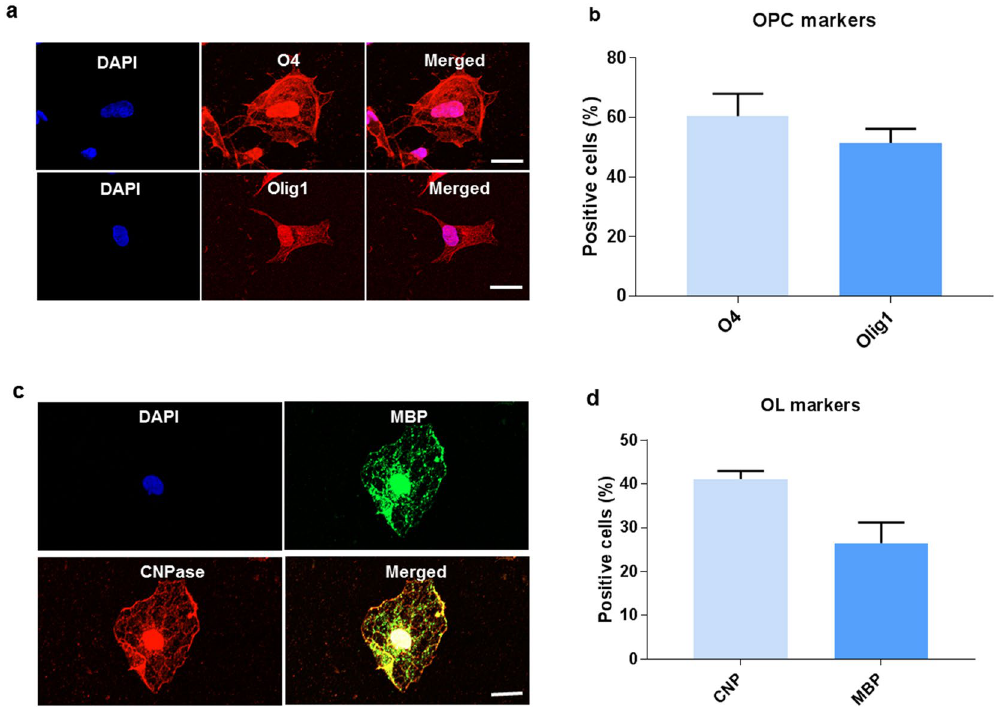
Figure 2. Characterisation of the oligodendrocyte precursor cells. ( a ) Representative immunofluorescence images of OPCs stained for O4 and Olig 1, ( b ) Estimate of the percentage of cells staining positive for OPC markers. ( c ) Representative immunofluorescence images of mature OLs stained for CNP and MBP, ( d ) Estimate of the percentage of cells staining positive for OL markers. Data represented as mean ± SEM. Scale bar = 2 µ